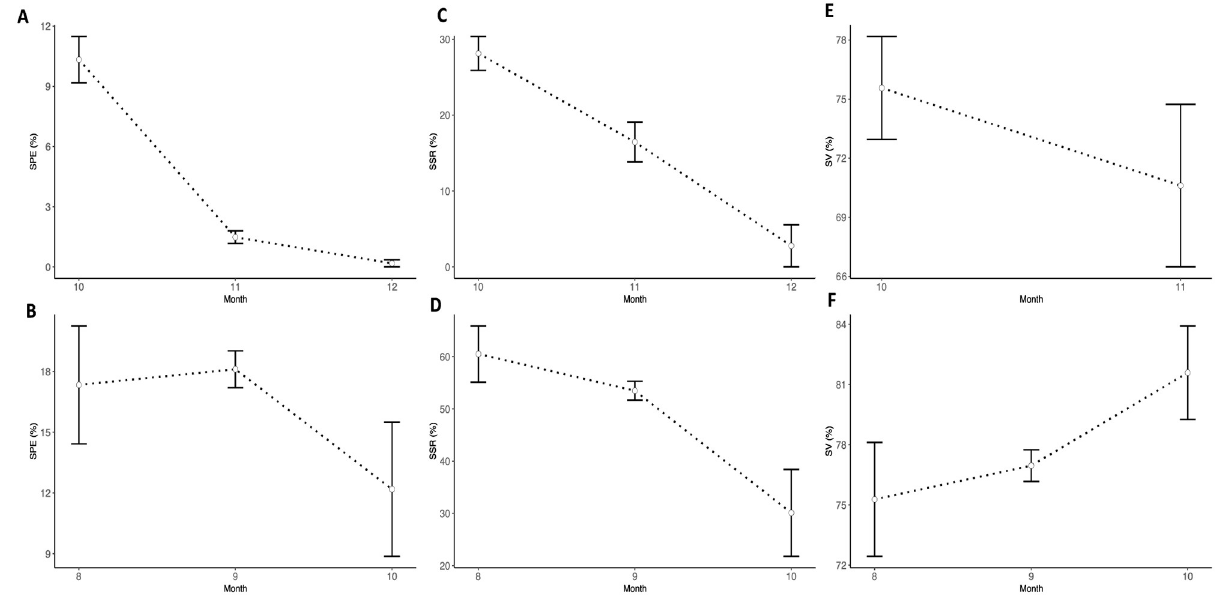
Fig 7. Dynamics of SPE, SSR and SV across crossing months. Monthly variability in SPE for D . alata (A) and D . rotundata (B), monthly variability in SSR for D . alata (C) and D . rotundata (D). Monthly variability in seed viability for D . alata (E) and D . rotundata (F). The number 8 refers to August and 12 to